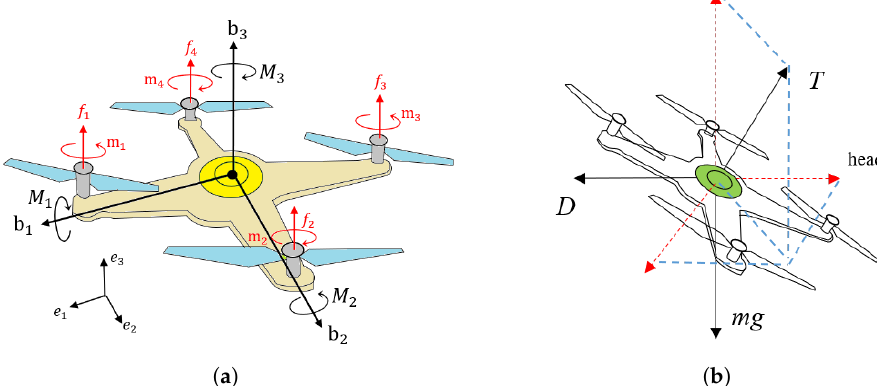
Figure 2. ( a ) The force and coordinate-system analysis. { e } represents the inertial reference frame, { b } stands for the rigid body frame, m i and f i are thrusts and torques produced by blades. ( b ) The external force analysis of the